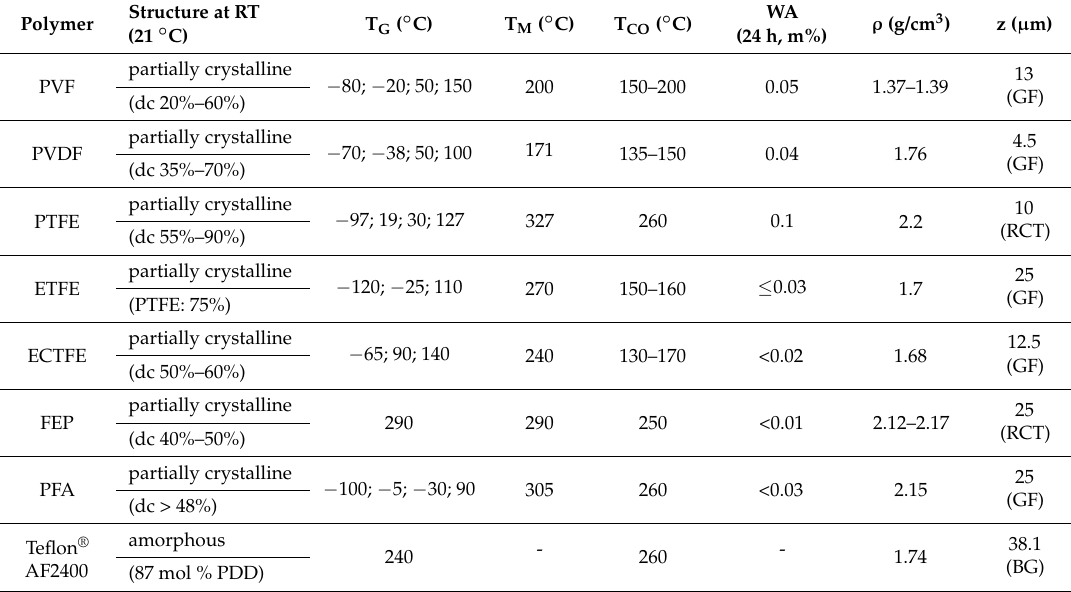
Table 1. Selected structural, thermal and mechanical properties of the fluoropolymers used in our study. dc refers to the degree of crystallinity, the glass transition temperature is T G , T M the crystallite melting point, T CO the continuous operating temperature, WA is water absorption in 24 h based on weight percent, the density ρ and z the thickness of the membrane sheet. Adapted from data sheets of the suppliers GoodFellow (GF), Reichelt Chemietechnik (RCT) and Biogeneral (BG)